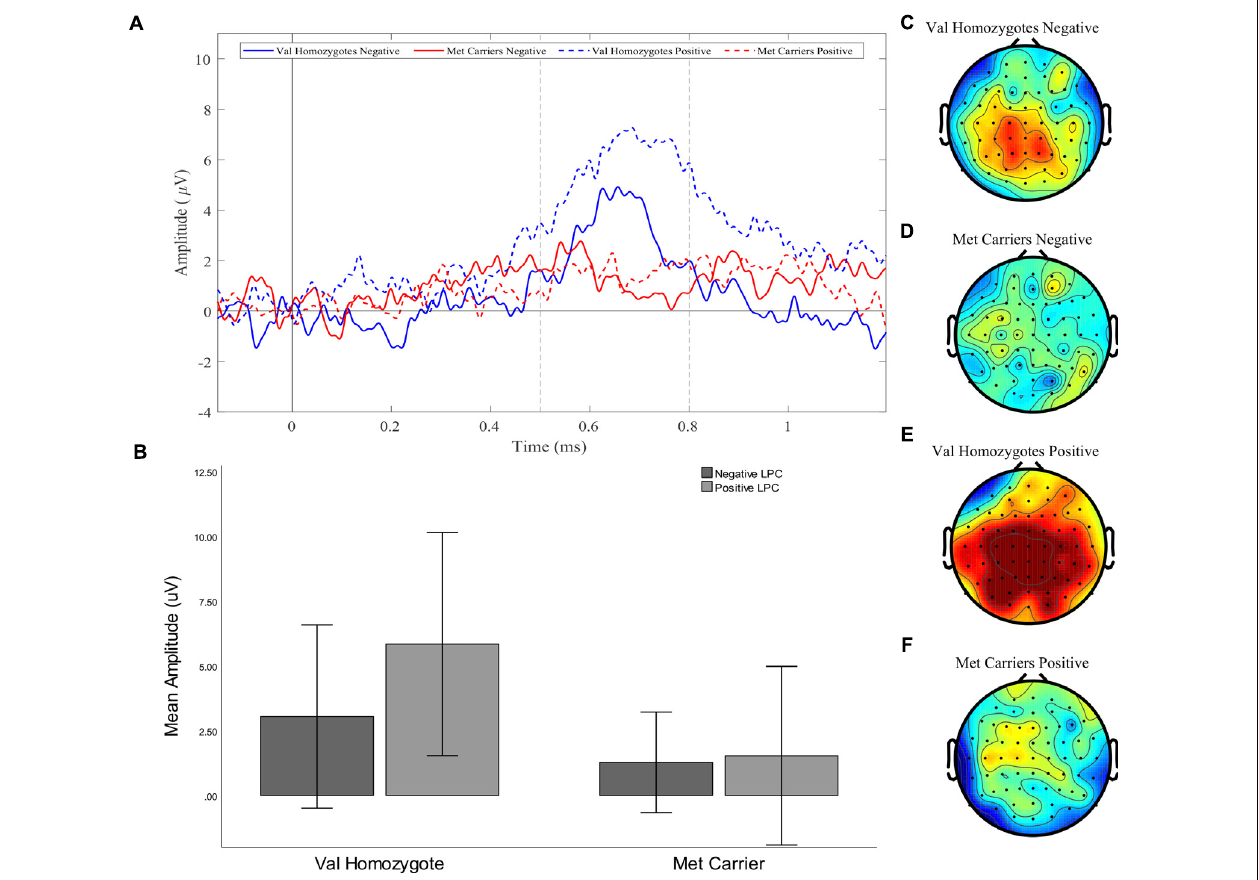
FIGURE 4 | Experiment 1: Old-New difference waves for the Val homozygotes (blue) and Met carriers (red) in negative (solid lines) and positive (dashed lines) conditions (A) . Mean ( ± 1SD) LPC amplitude of Val homozygotes (left within graph) and Met carriers (right within graph) for the positive (light gray) and negative (dark gray) conditions (B) . Topographic distribution of LPC effect between 500–800 ms in Val homozygotes negative condition (C) , Met carriers negative condition (D) , Val homozygotes positive condition (E) , and Met carriers positive condition (F)